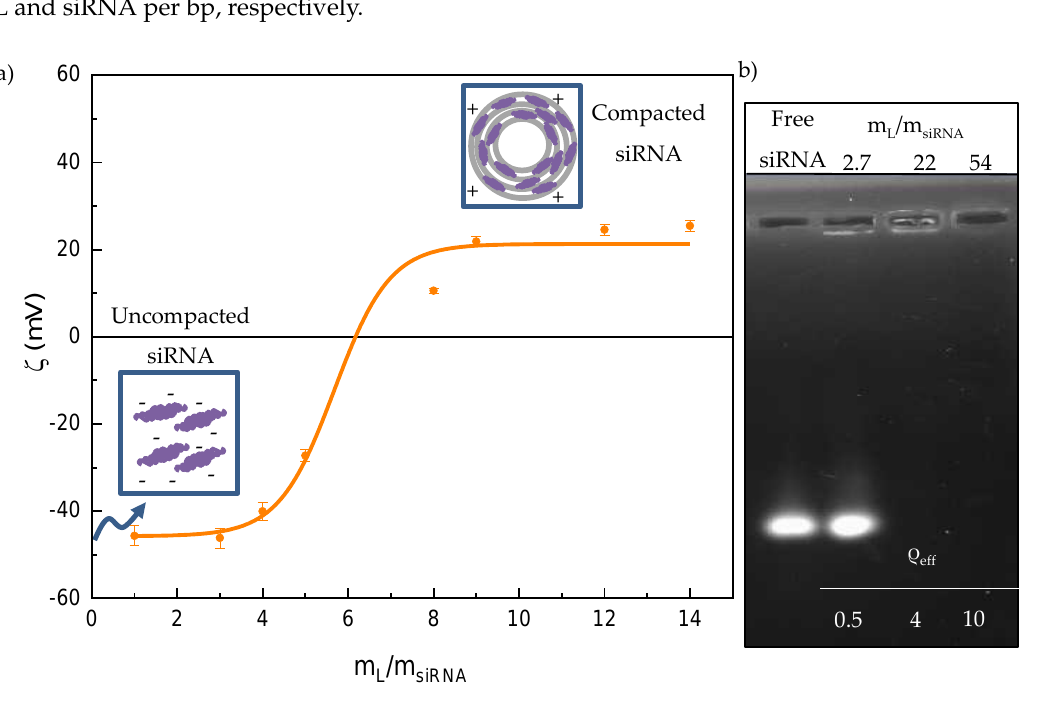
Figure 1. ( a ) Plot of the ζ vs. mass ratio (m L /m siRNA ) of C 3 (C 16 His) 2 / MOG-siRNA lipoplexes at α = 0.2. ( b ) Agarose gel electrophoresis of the lipoplexes formed at selected m L /m siRNA (or ρ e ff ) and α = 0.2 (2–4 lanes). Used as control: free siRNA (lane 1).